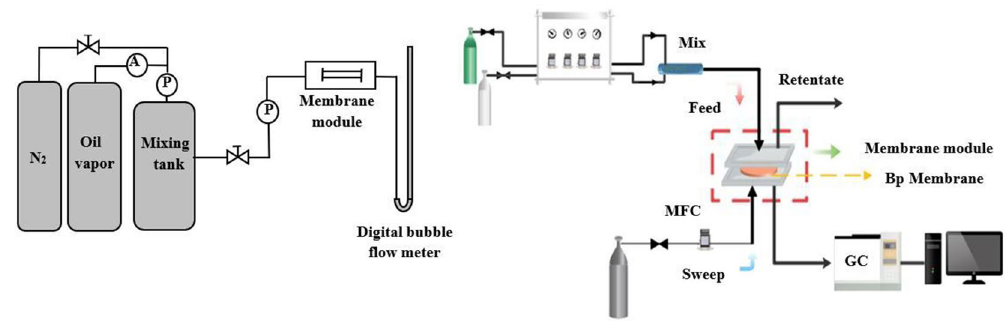
Figure 1. Device of the oil vapor separation